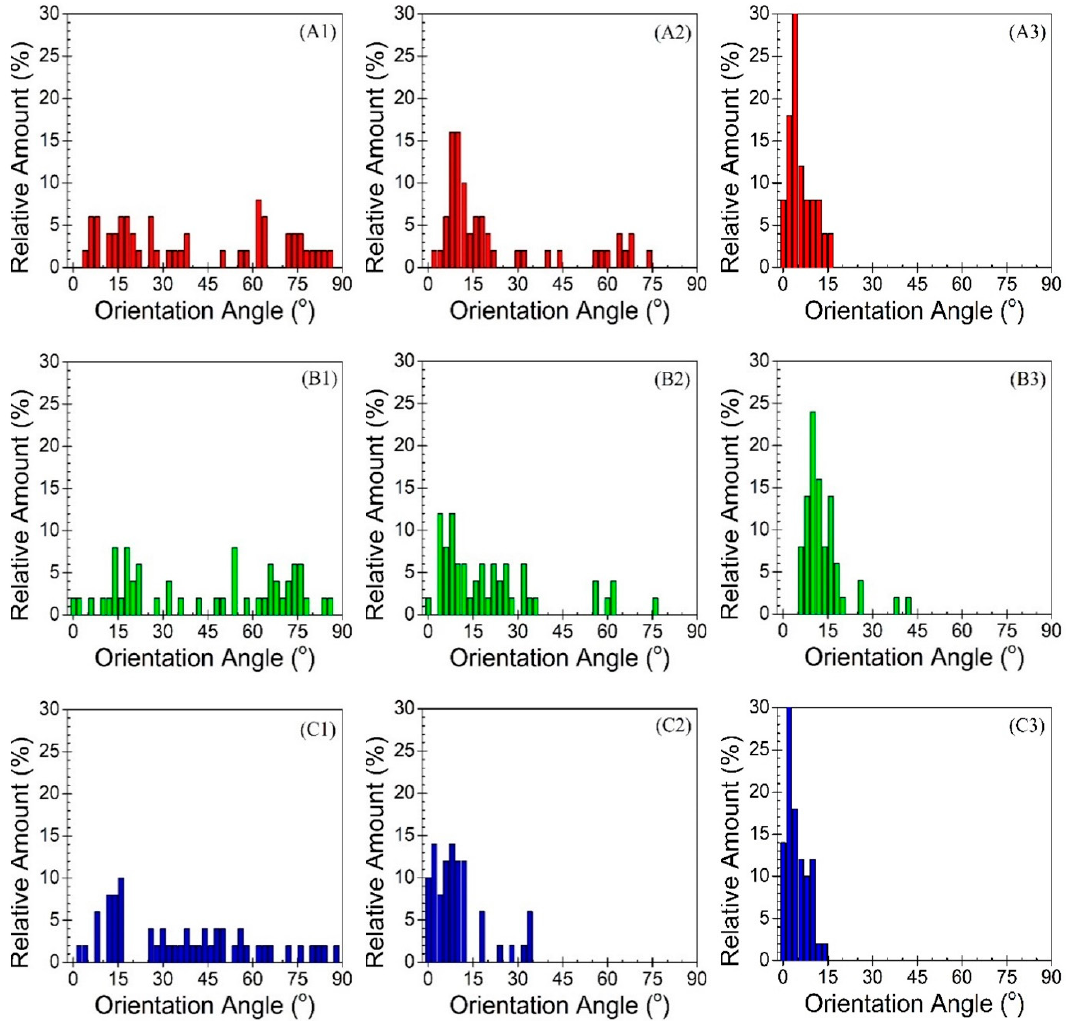
Figure 6. Distributions of PET nanofiber orientation angles with respect to the MD. 0 ◦ indicates perfect alignment along the MD, 90 ◦ indicates orientation of fibers transverse to the MD, and 45 ◦ implies random orientation. ( A – C ) denote PET concentrations of 3, 7, and 15 wt.%, respectively. 1, 2, and 3 denote low extreme, intermediate, and high extreme processing conditions, respectively. Table 3. Average angles of orientation and standard deviations of PET fibers along the MD.